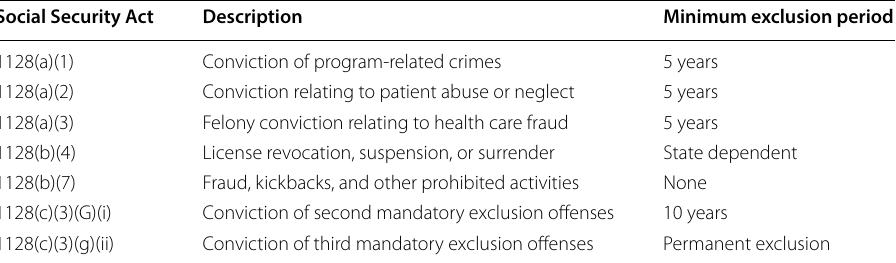
Table 3 Fraud related LEIE rules [69] Social Security